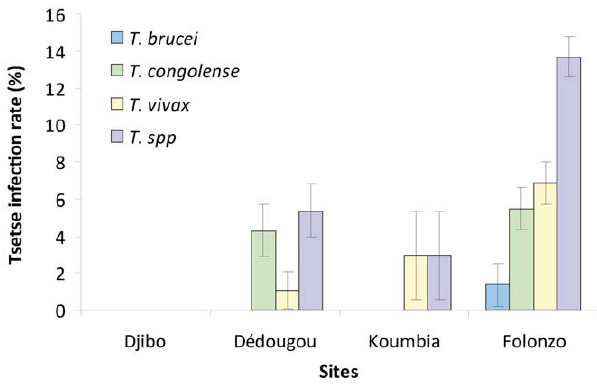
Figure 3. Tsetse infection rates along the aridity gradient. Sites are ordered by increasing annual rainfall from the left to the